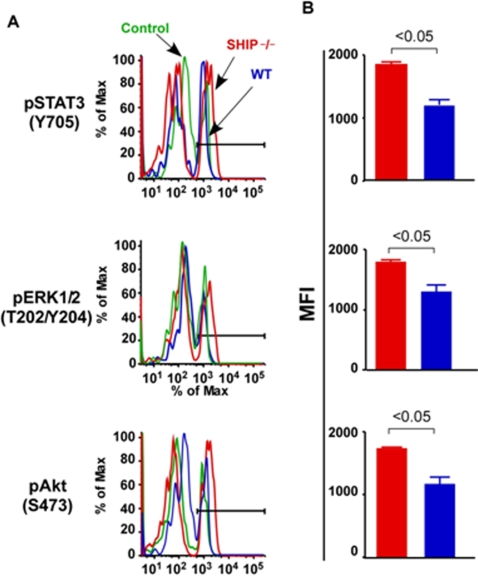
Increased phosphorylation of signaling proteins in SHIP−/− MKP in BM.(A) Histogram representing the level of phospho-STAT3, phospho-Erk1/2 and phospho-Akt in Lin−c-kit+CD41+ BM cells isolated from SHIP−/− (black line) and WT (gray line) mice. Isotype antibody control indicated on the histogram. (B) Represented is the mean±SEM of the mean fluorescence (MFI) intensity of phospho-STAT3, phospho-Erk1/2 and phospho-Akt on SHIP−/− (−/−) (n = 4) and WT (n = 4) Lin−c-kit+CD41+ in BM. Significance was established using the Mann-Whitney test. p values indicated on each graph.